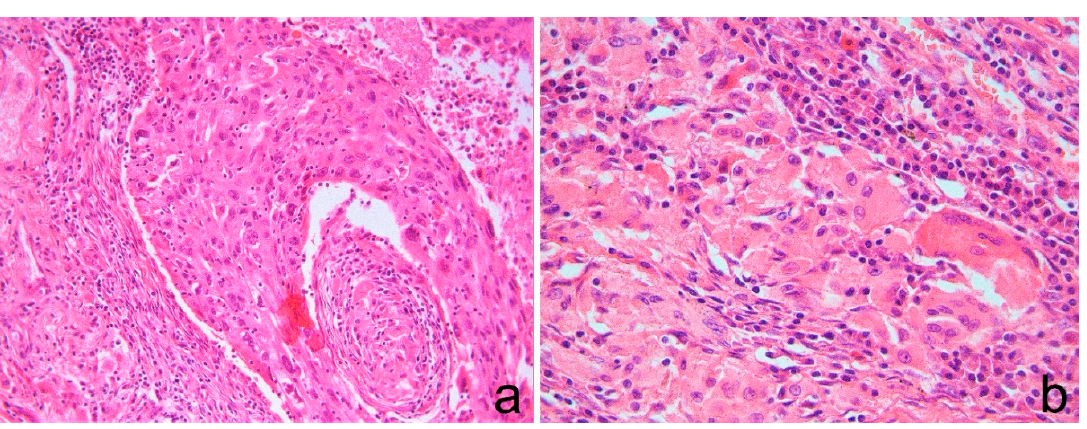
Figure 1. ( a ) Neoplastic solid nests formed by ( b ) cells with large, eosinophilic cytoplasm with an apparent tendency to keratinization. ( a , b ) Hematoxylin and eosin stain. Original magnification: ( a ) 200×; ( b ) 400×.